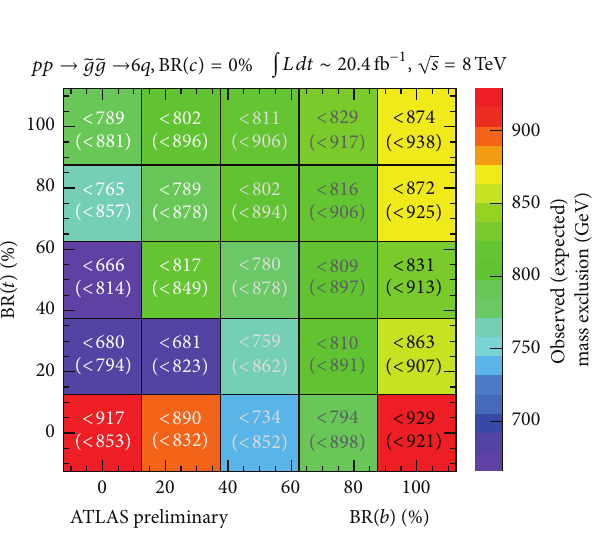
Figure 5: Highest mass excluded at 95% CL in the search for heavy flavor three-body decay of gluino in RPV supersymmetry [11]. Vertical and horizontal axes indicate the branching fraction into 𝑏 and 𝑡 quarks and the colored boxes indicate the corresponding highest excluded mass, as indicated by the color coded legend as